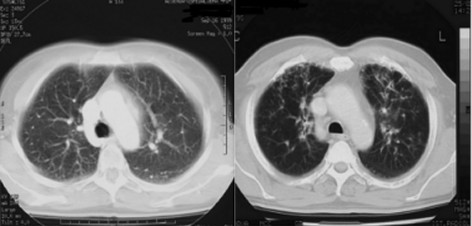
Computed tomography scan during the interferon treatment. Computed tomography scan, performed after the 20th week for DD/DI patient (left) and during the 52nd week for HDI patient (right), confirmed mild ground-glass opacities in both lungs with bronchial wall and interstitial thickening. Sputum cultures were negative for bacteria, fungi, and acid-fast bacilli.